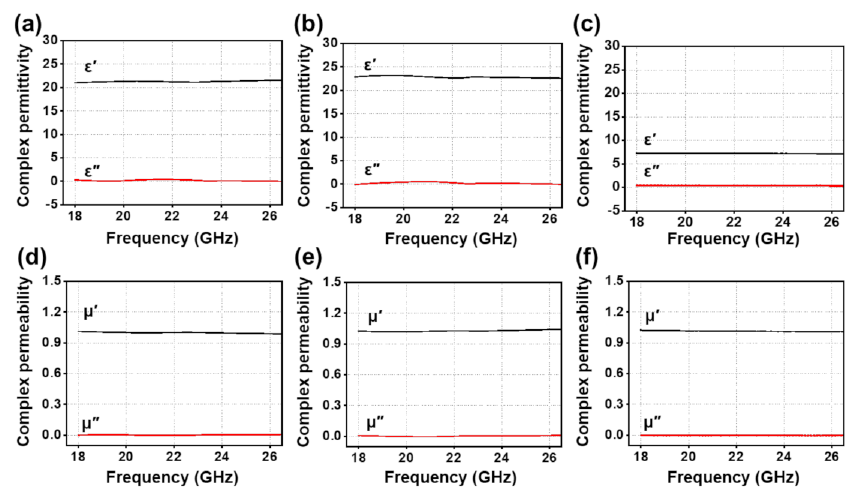
Figure 8. Complex permittivity of sintered ( a ) 3YSZ, ( b ) 8YSZ, and ( c ) 30YSZ over the K − band frequency, and complex permeability of sintered ( d ) 3YSZ, ( e ) 8YSZ, and ( f ) 30YSZ over the K − band